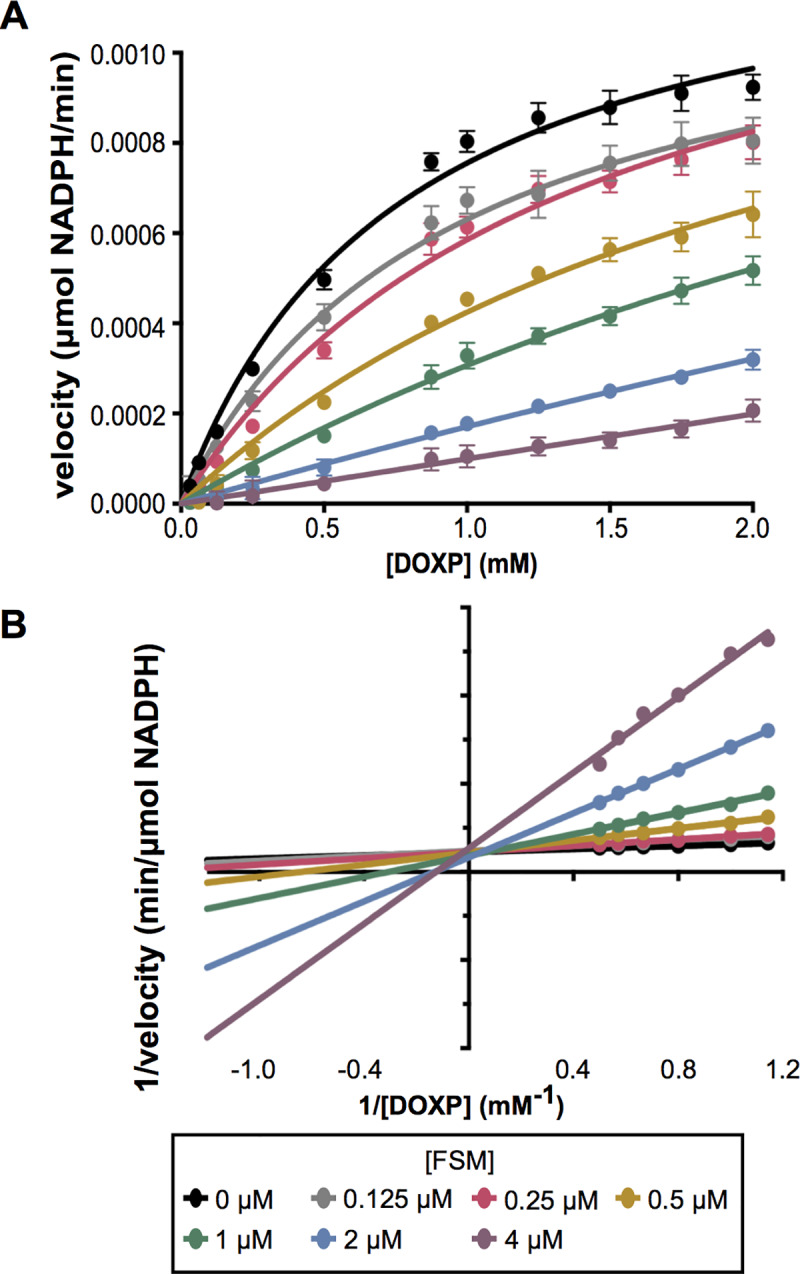
Inhibition of staphylococcal DXR by FSM is competitive with DOXP.(A) S. schleiferi DXR velocity in μmol NADPH/min with respect to the DOXP concentration in mM. Displayed are the means ± SD from three independent experiments. (B) Lineweaver−Burk double reciprocal plots of S. schleiferi DXR activity over a range of DOXP substrate concentrations, for illustrative purposes only.